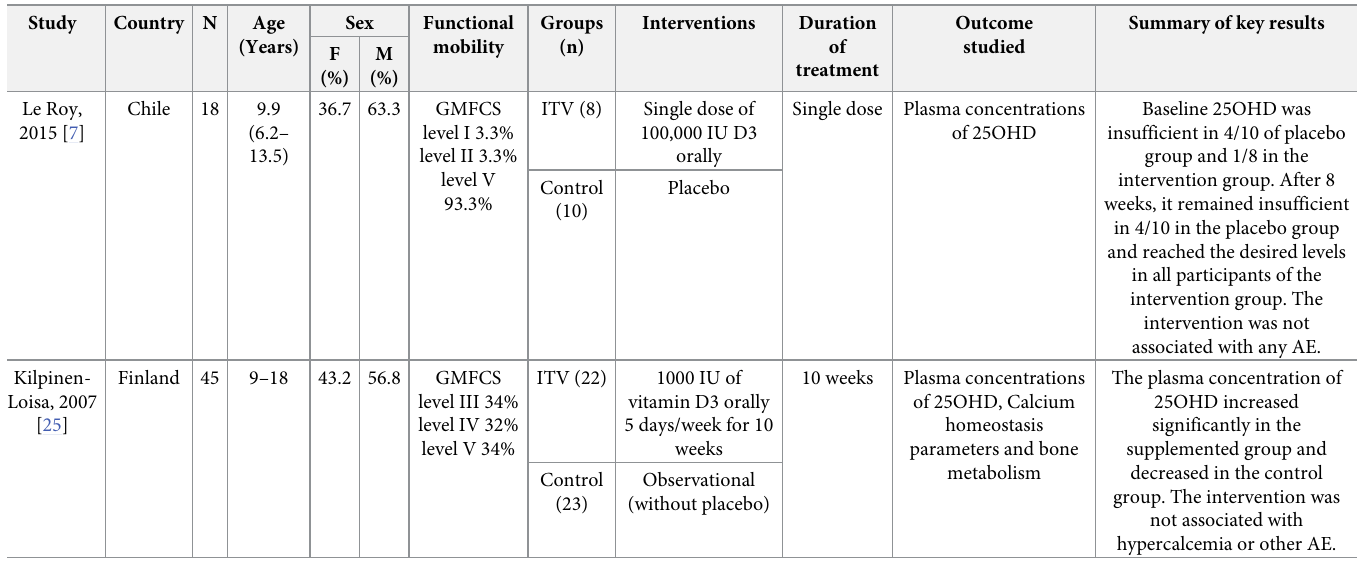
Baseline 25OHD was insufficient in 4/10 of placebo group and 1/8 in the intervention group. After 8 weeks, it remained insufficient in 4/10 in the placebo group and reached the desired levels in all participants of the intervention group. The intervention was not associated with any The plasma concentration of 25OHD increased significantly in the supplemented group and decreased in the control group. The intervention was not associated with hypercalcemia or other